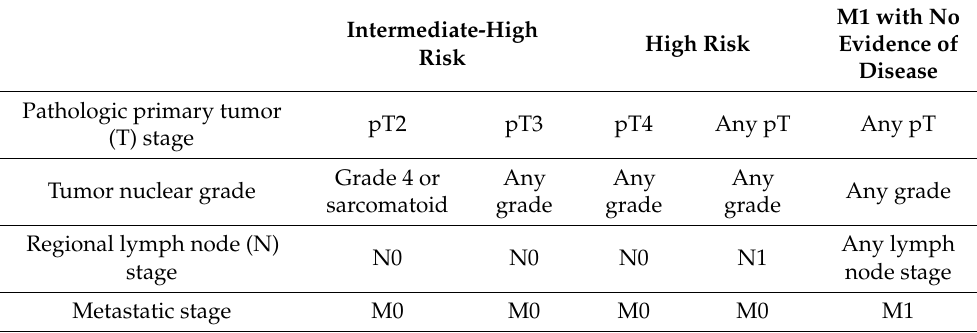
Table 1. Prespecified disease risk categories for each enrolled patient used by the KEYNOTE-564 randomized clinical trial of adjuvant pembrolizumab versus placebo control in patients with clear cell renal cell carcinoma [9]. Pathologic primary tumor (T) stage Tumor nuclear grade